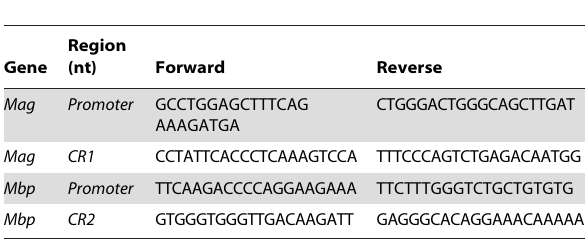
Table 3. Primers used for ChIP of mouse chromatin samples.